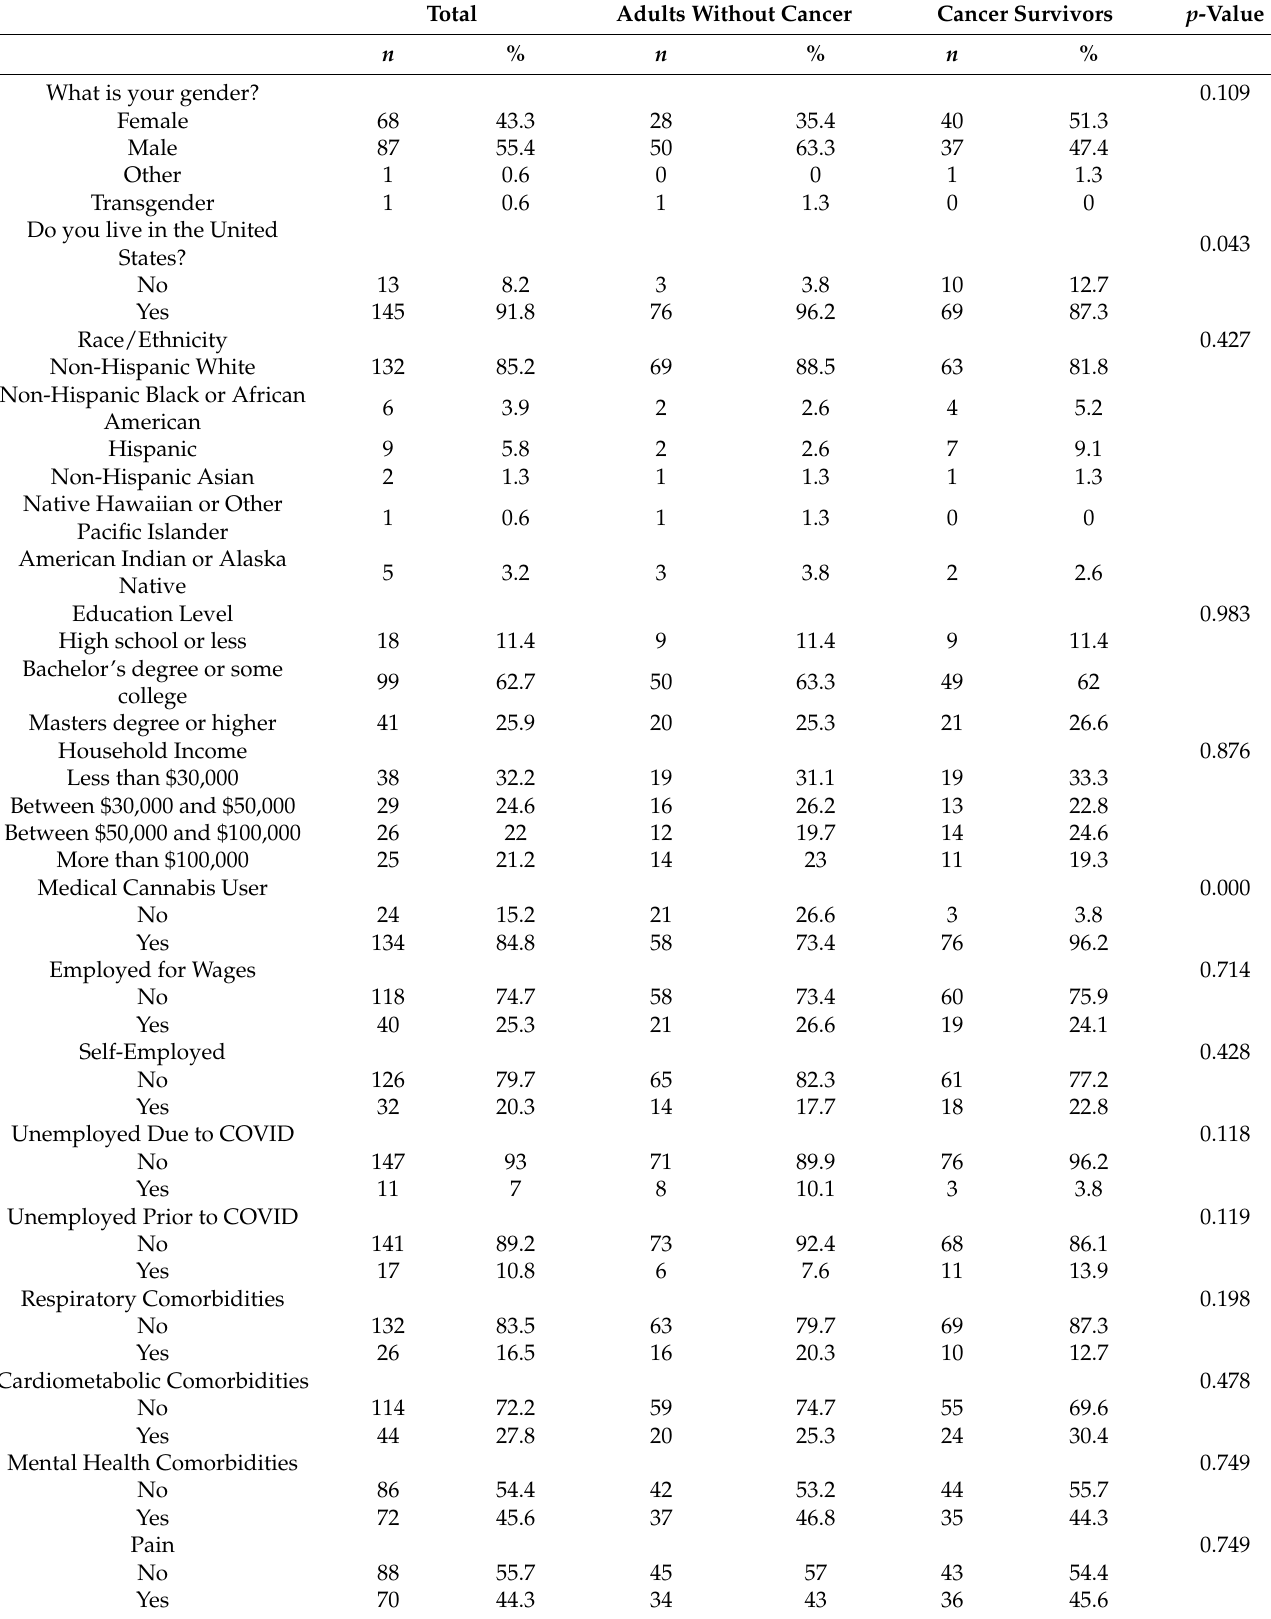
Table 1. Demographic Characteristics of COVID-19 Cannabis Health Questionnaire Respondents (21 March 2020 to 23 March 2021) among age-matched Cancer Survivors ( n =